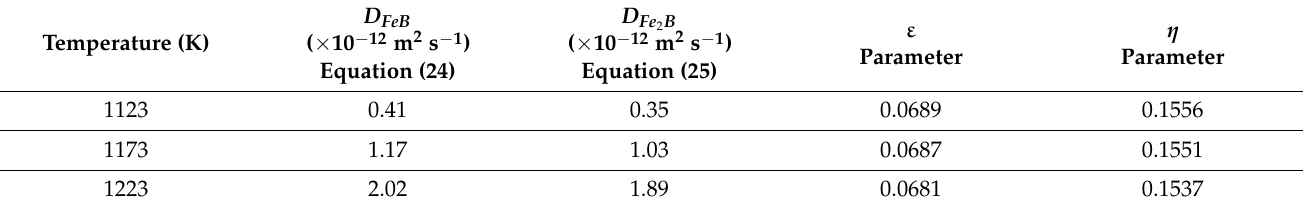
Table 4. Assessed boron diffusion coefficients in in iron borides with Equations (24) and (25).